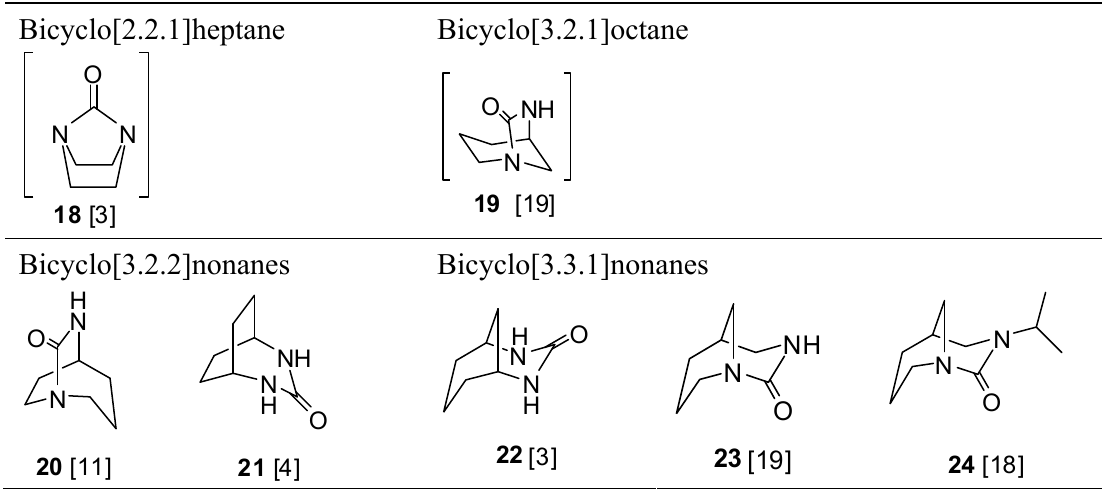
Table 2. Bicyclic urea monomers 18–30 [3,4,11,18,19].